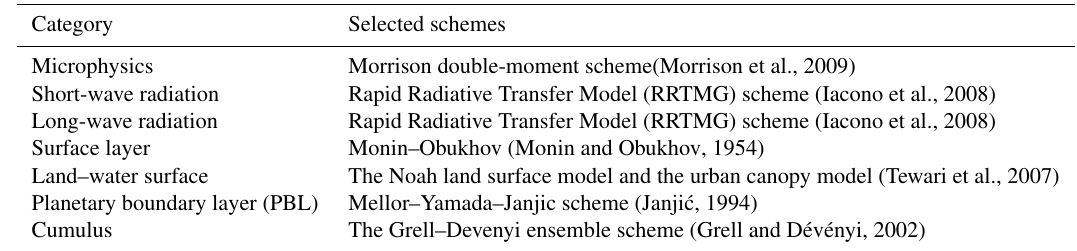
Table 1. Physics parameterizations used in WRF model